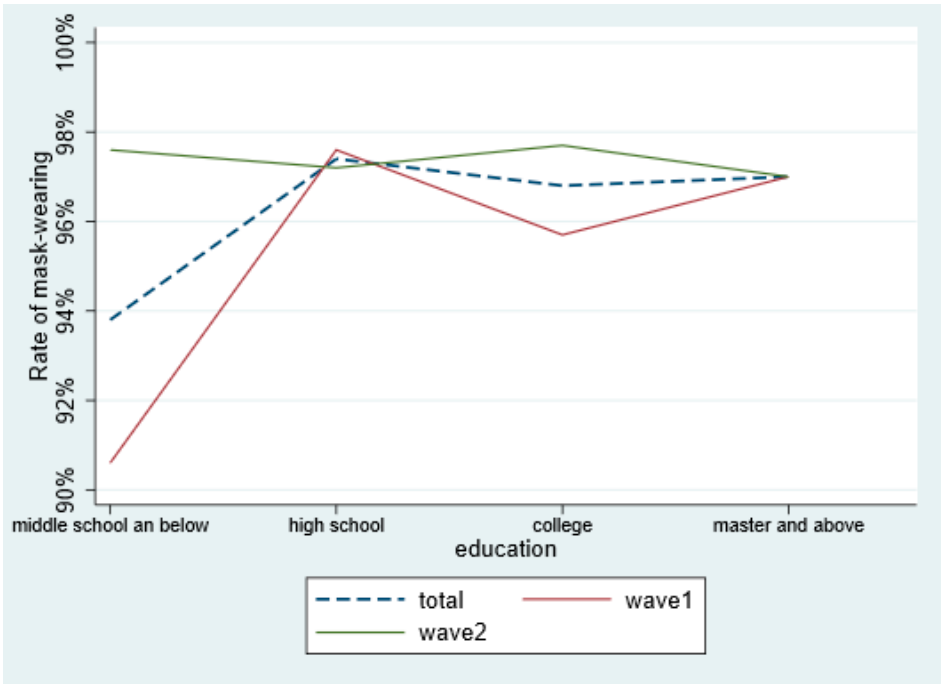
Figure 2. Comparison of the rate of wearing masks people with different education in two surveys.